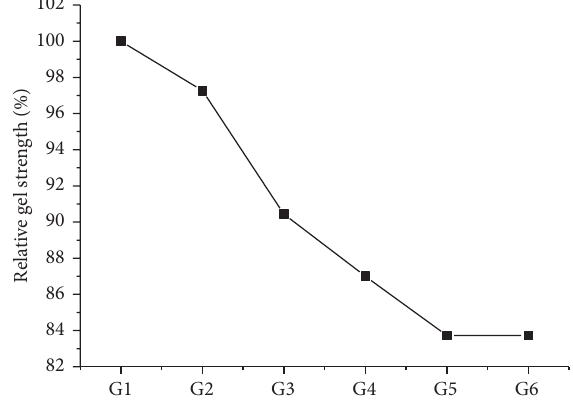
Figure 6: Relative gel strength as a function of the hydrogel composition and NaSal content. Table 2: Dynamic yield stress and gel strength of the